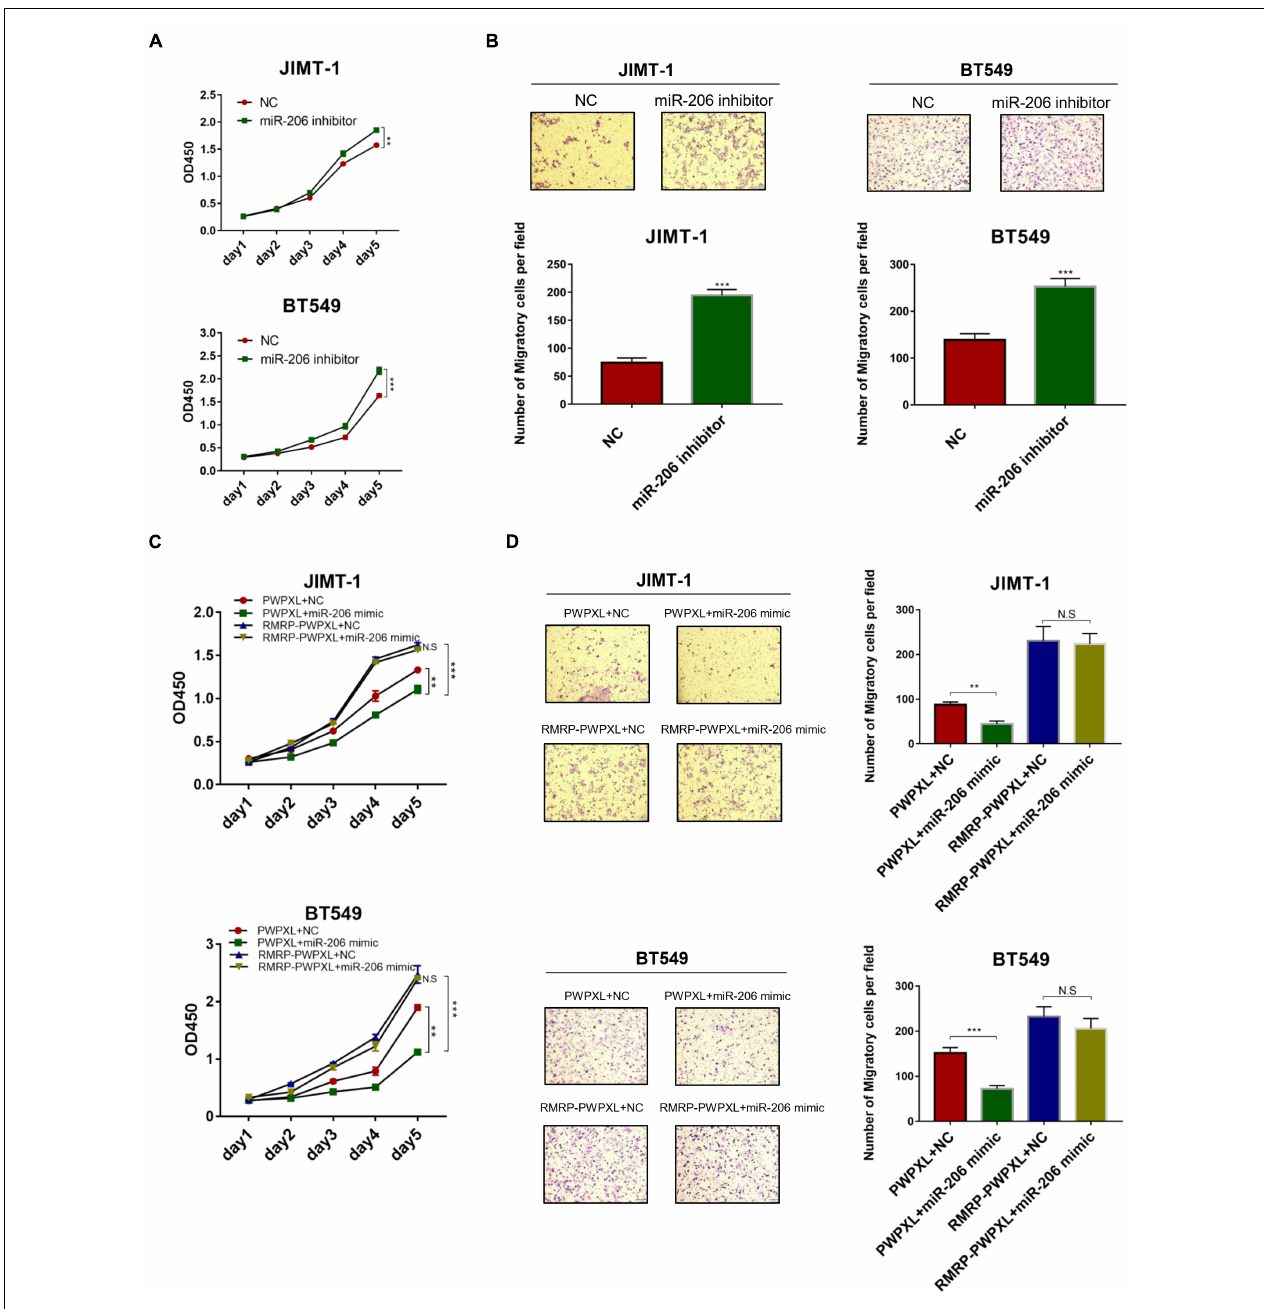
FIGURE 5 | RMRP negates the tumor suppressive function of miR-206. (A) Inhibition of miR-206 promotes JIMT-1 and BT549 cell proliferation determined by the CCK-8 assay. (B) Inhibition of miR-206 promotes JIMT-1 and BT549 cell migration determined by the Transwell assay. (C) RMRP overexpression abrogates miR-206 inhibition of cell proliferation determined by the CCK-8 assay. (D) RMRP overexpression abrogates miR-206 inhibition of cell migration determined by the Transwell assay. ** p < 0.01, *** p <